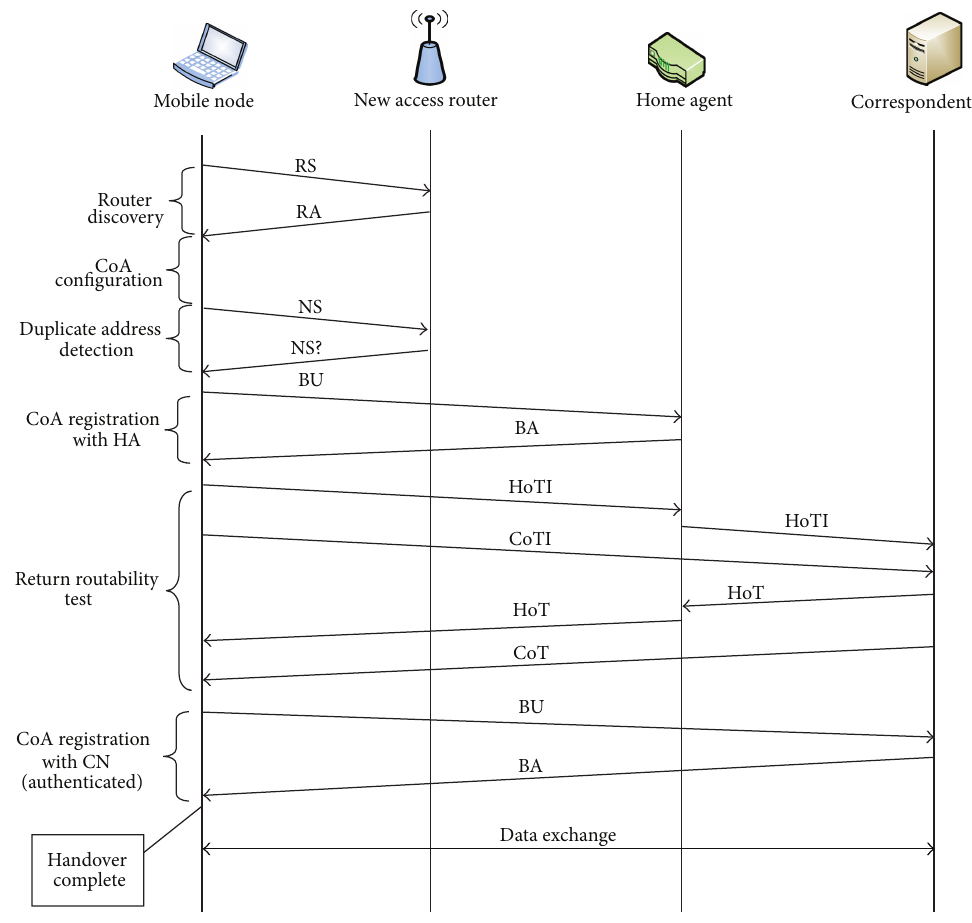
Figure 2: Mobile IPv6 Route Optimization using Return Routability sequence